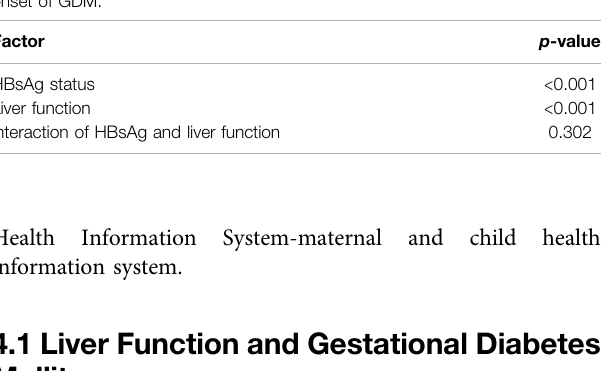
TABLE 3 | GDM prevalence in different groups.